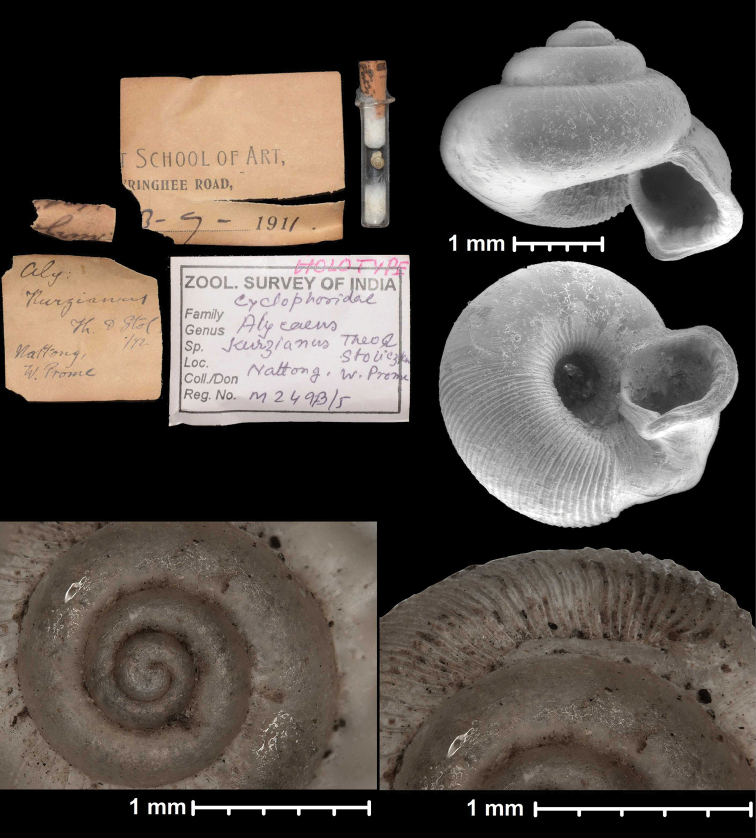
Dicharax
(?)
kurzianus (Theobald & Stoliczka, 1872) Nattoung, W. Prome, coll. Theobald, syntype (NZSI M.24974). All images: Sheikh Sajan.